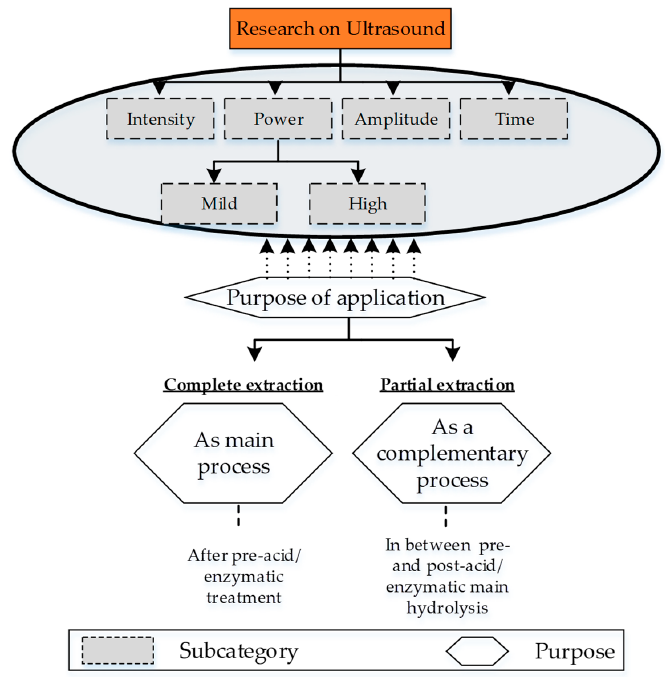
Figure 5. Hierarchical segregation for ultrasound-based collagen extraction.